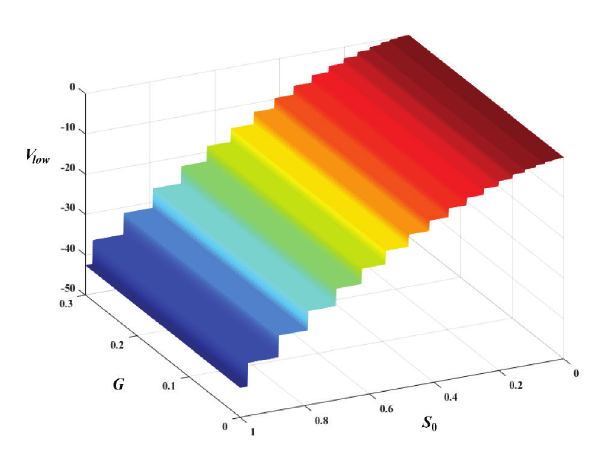
Figure 10. Relationship between low V , S 0 and